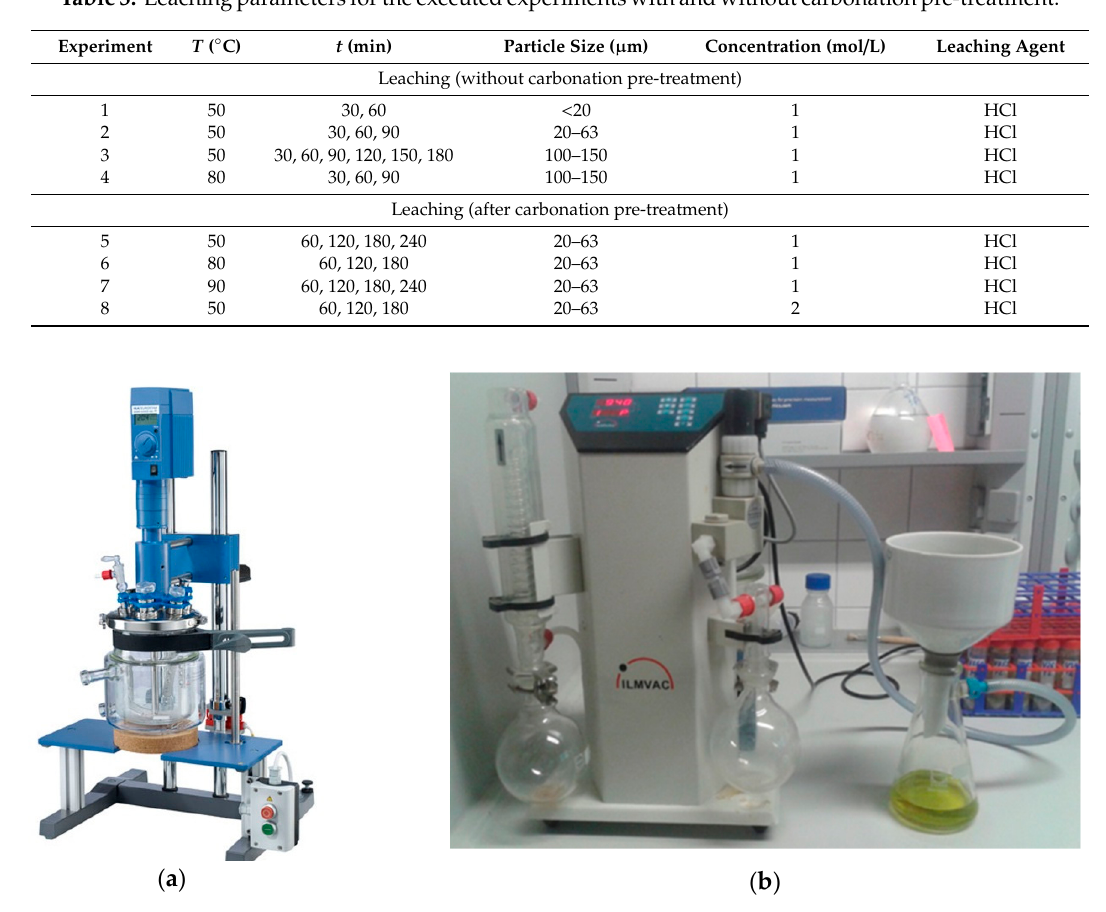
Figure 2. ( a ) Leaching laboratory reactor; ( b ) Filtration unit.